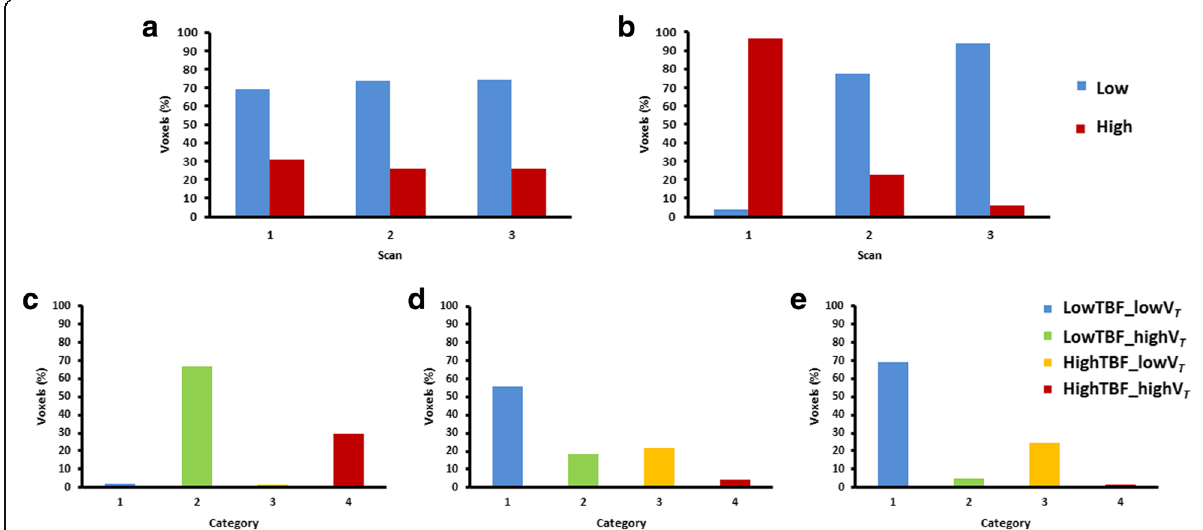
Fig. 4 Independent ( a , b ) and multiparametric ( c , d , e ) classification of one lesion. The independent classification shows the percentage of voxels classified in the “ low ” or “ high ” category for TBF ( a ) and [ 18 F]FLT V T ( b ), for the three time scan time points: baseline (1), 7 days post-therapy (2) and 28 days post-therapy (3). The multiparametric classification shows the percentage of voxels in each category of the classification, for all the three time points: baseline ( c ), 7 days post-therapy ( d ) and 28 days post-therapy ( e ). Voxels are classified into four categories using the global threshold